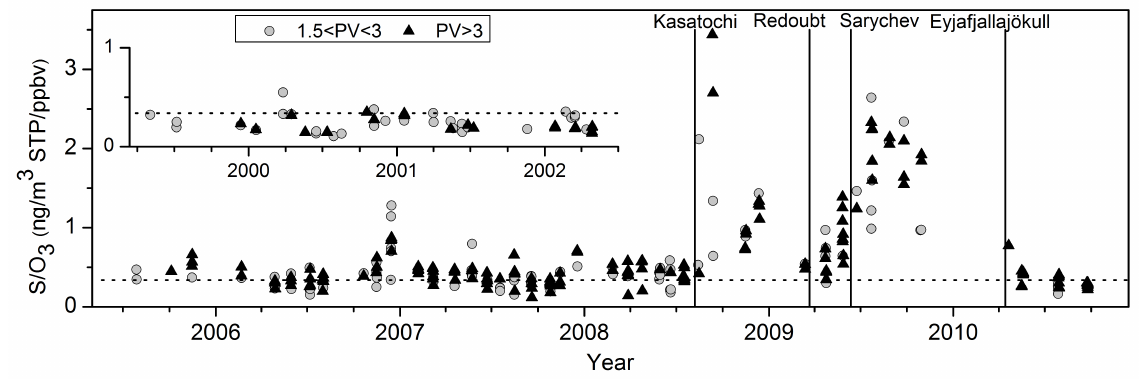
Fig. 1. Ratio of particulate sulphur to ozone concentration in aerosol samples collected in the tropopause region (grey circles) and the lowermost stratosphere (black triangles). The dotted line indicates the geometrical mean of samples collected before the eruption of Kasatochi in August 2008. The occasions of major eruptions are marked by vertical